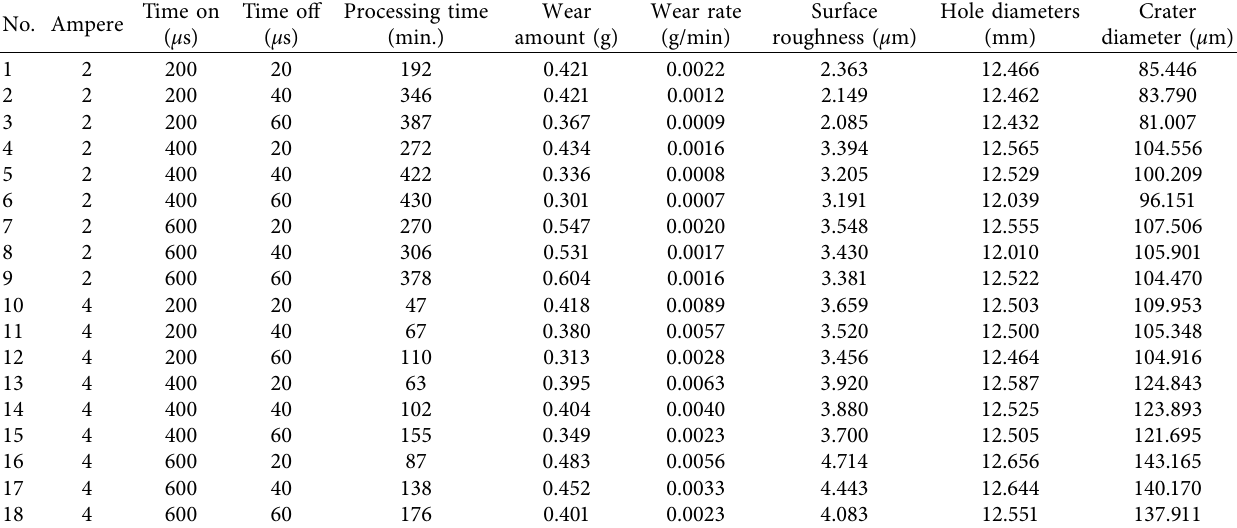
Table 3: Test parameters and output parameters obtained after processing.